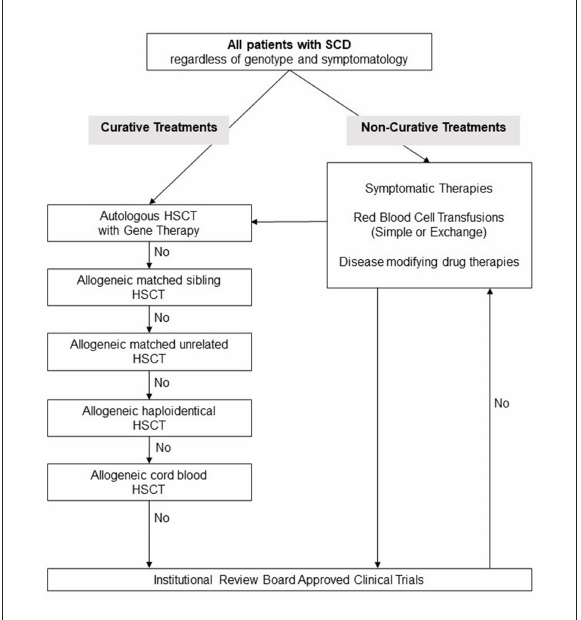
FIGURE1 Suggested management algorithm for patients with sickle cell disease. SCD, Sickle Cell Disease; HSCT, hematopoietic stem cell